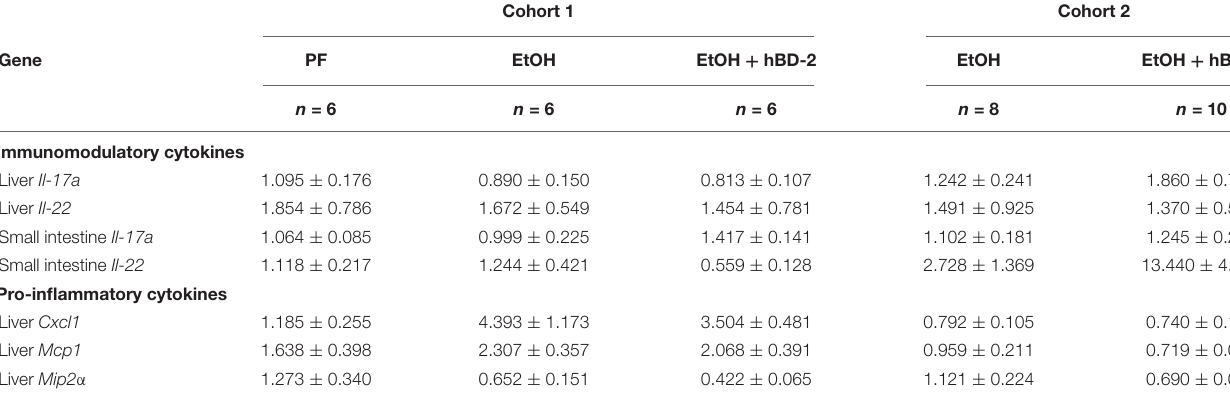
TABLE 4 | Liver and small intestine mRNA expression of immunomodulatory or pro-inflammatory cytokines in PF or EtOH-fed control or hBD-2-treated mice. Cohort 1